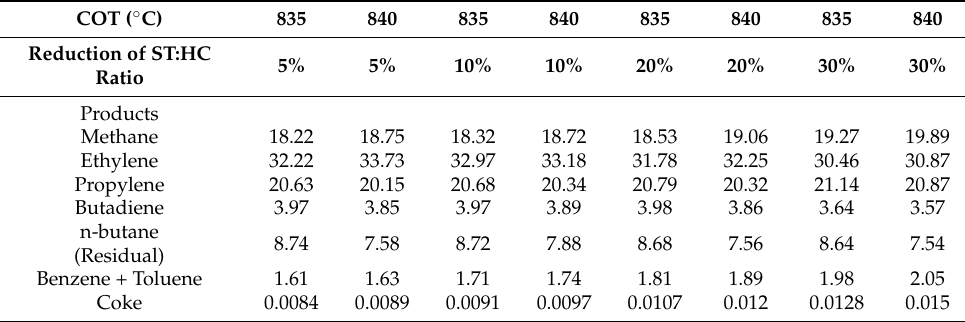
Table 5. Effect of the steam-to-hydrocarbon ratio on the product yields